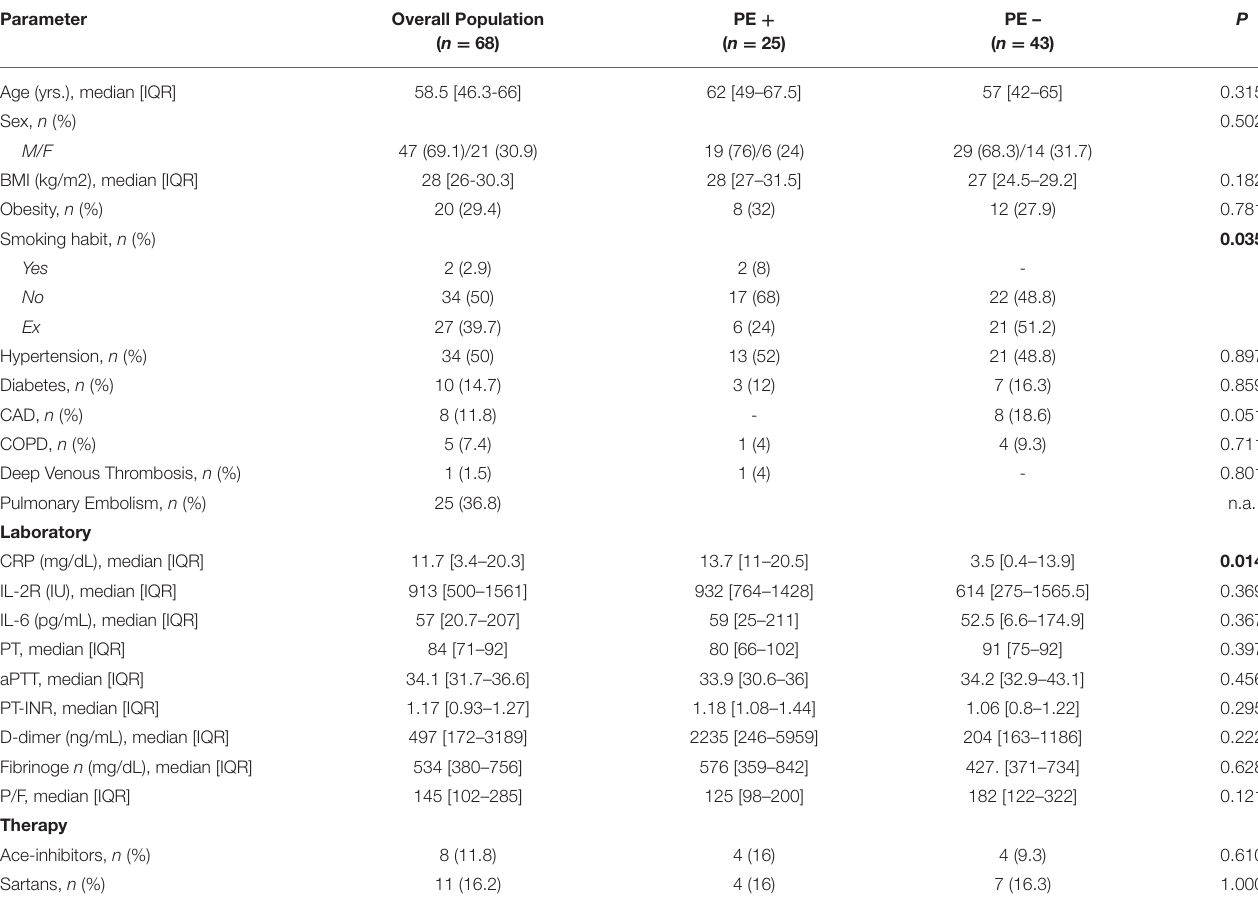
TABLE 1 | Baseline clinical and laboratory characteristics of the overall study population and study subgroups according to the presence of pulmonary embolism (PE + and PE − ) ( n = 68).